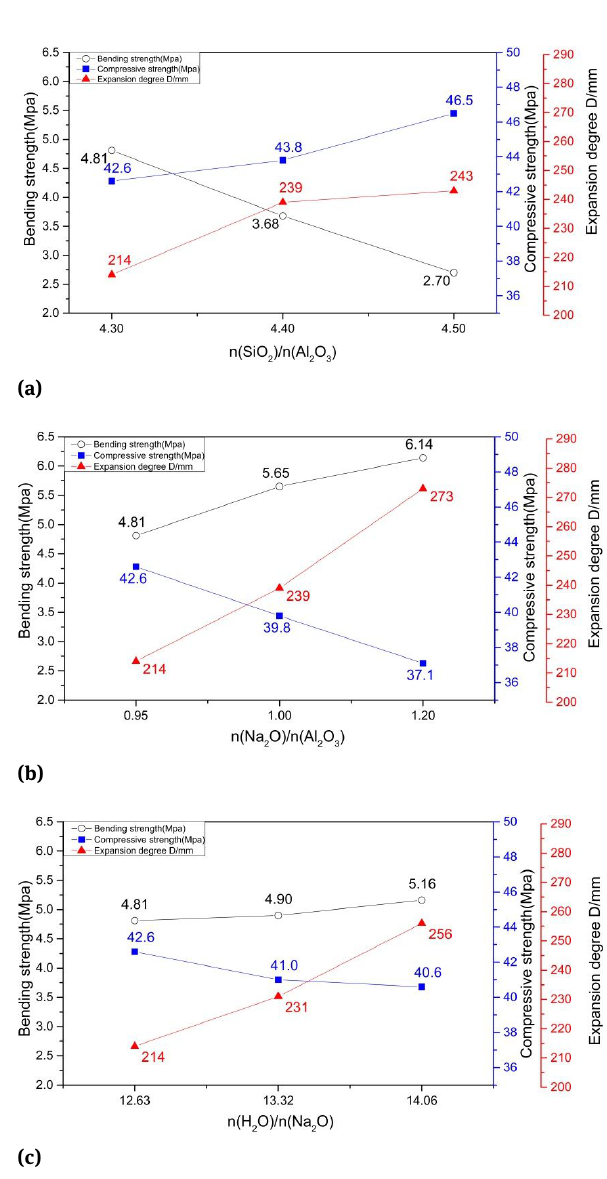
Figure 1: Effect of different molar ratios (a) S/A, (b) N/A and (c)